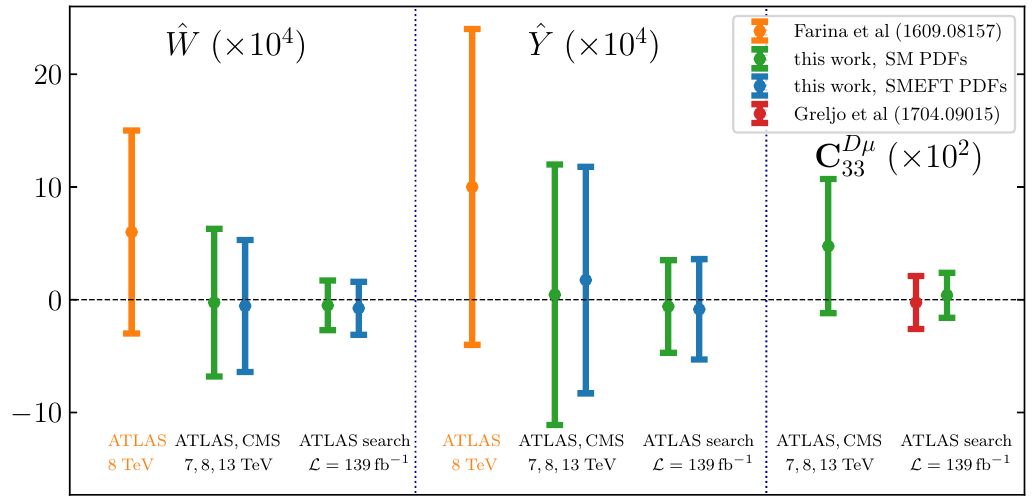
Figure 11 . Overview of the results obtained in this section concerning the EFT parameters ˆ W and ˆ Y (in scenario I) and C Dµ (in scenario II). We compare the 95% CL bounds derived in [32] 33 with those obtained in this work from the high-mass DY cross section measurements (table 4) and from the ATLAS Z 0 search data (table 5), in both cases displaying the results obtained with either the SM or the SMEFT PDFs. In the former case, we indicate the results that account for PDF uncertainties; these are included by construction for the SMEFT